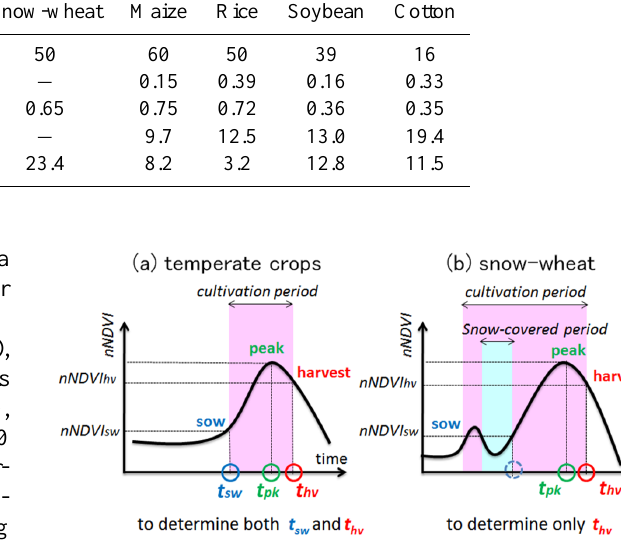
Figure 7. Scheme of identification of sowing and harvesting dates in this study. Sowing and harvesting dates ( t sw and t hv ) are identi- fied together with a vegetation index time series (black lines) and two crop calendar (CC) parameters: nNDVI sw and nNDVI hv . (a) and (b) indicate temperate crops (temperate-wheat, maize, rice, soy- bean, and cotton) and snow-wheat, respectively. The two CC param- eters are defined for the six crop types (Table